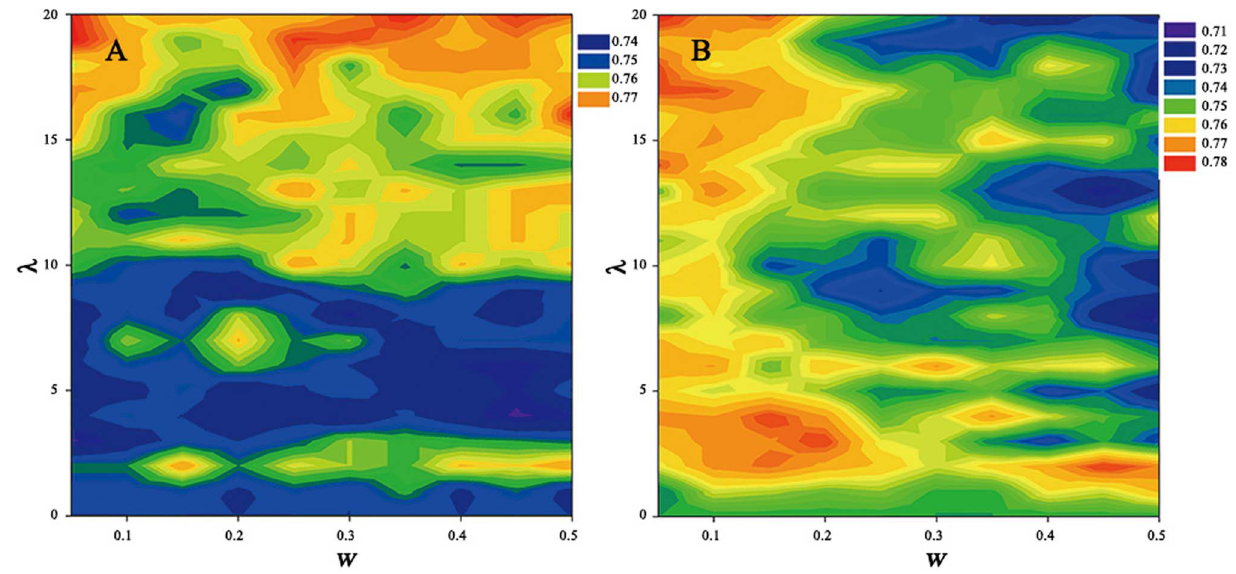
Figure 1. The effect of parameter settings on the prediction performance of Presep for Type I (A) and Type II (B) PseAAC modes. The x -axis represents the weight factor ( w ), and the y -axis represents the lambda parameter ( l ). Colour changes indicate differences in the Matthews correlation coefficient (MCC).